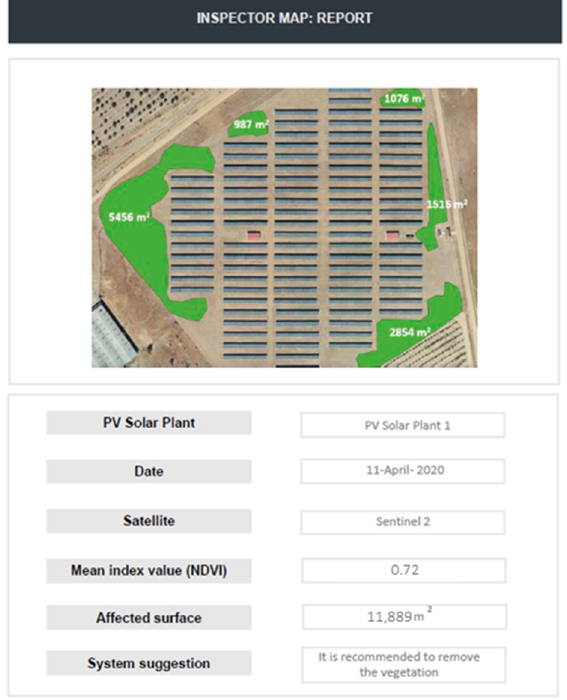
Figure 7. Standard report generated by the SDI INSPECTORMAP when the alert system is